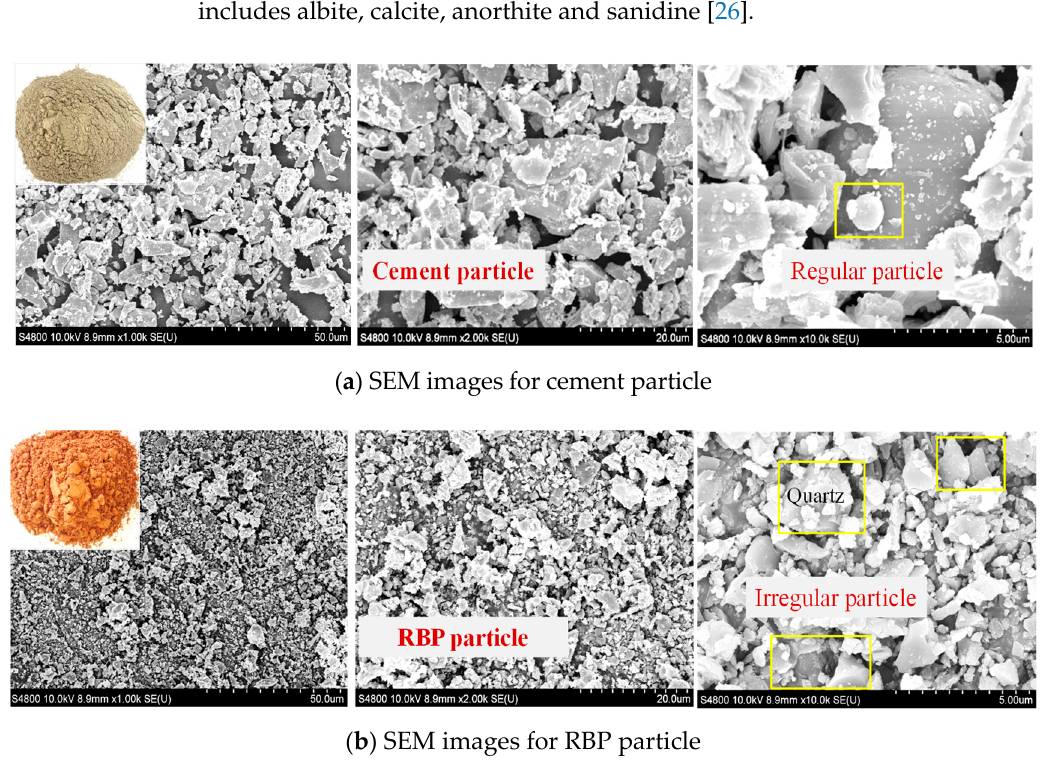
Figure 2. Micro-structure of cement and recycled brick powder (RBP) particles. Table 1. Properties of natural sand and recycled brick aggregate (RBA).